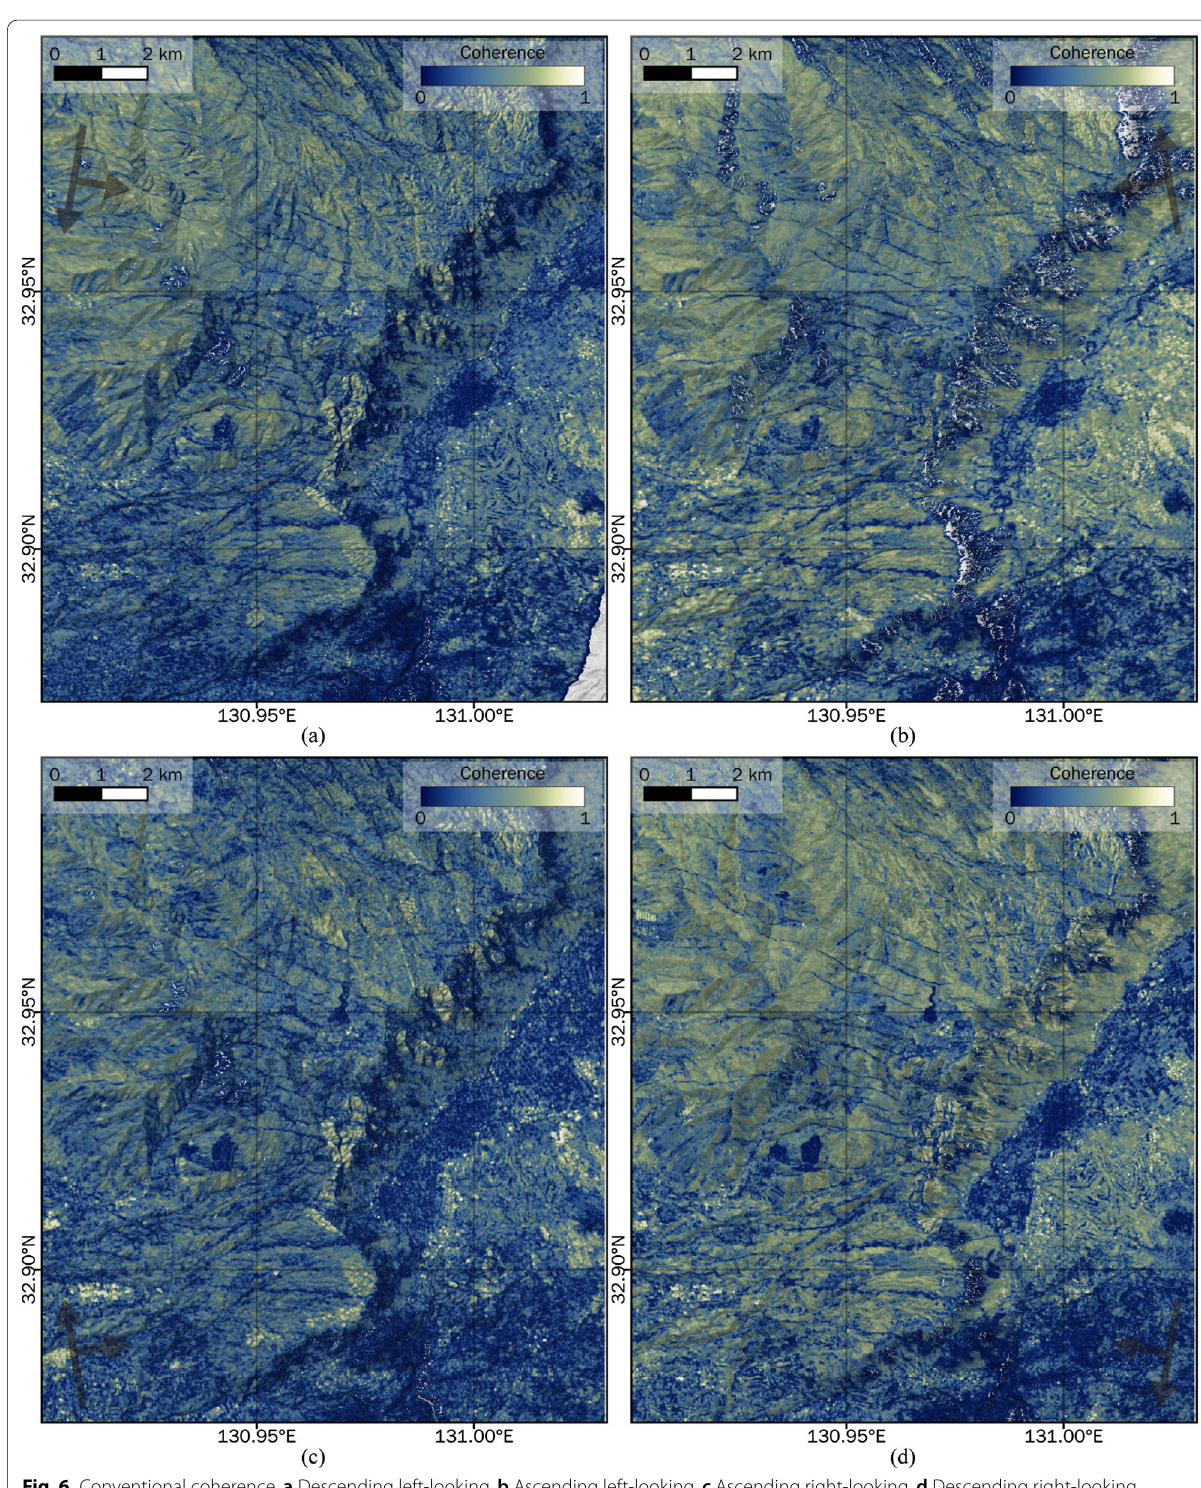
Fig. 6 Conventional coherence. a Descending left-looking. b Ascending left-looking. c Ascending right-looking. d Descending